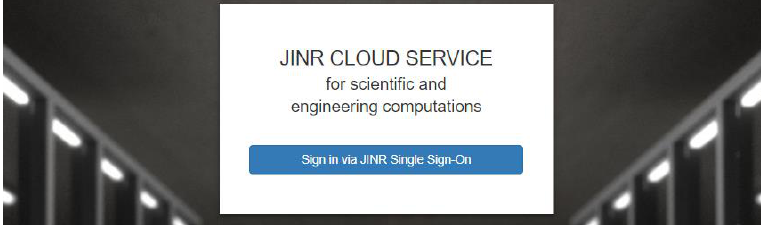
Fig. 3. A screenshot of the JINR SaaS login page.